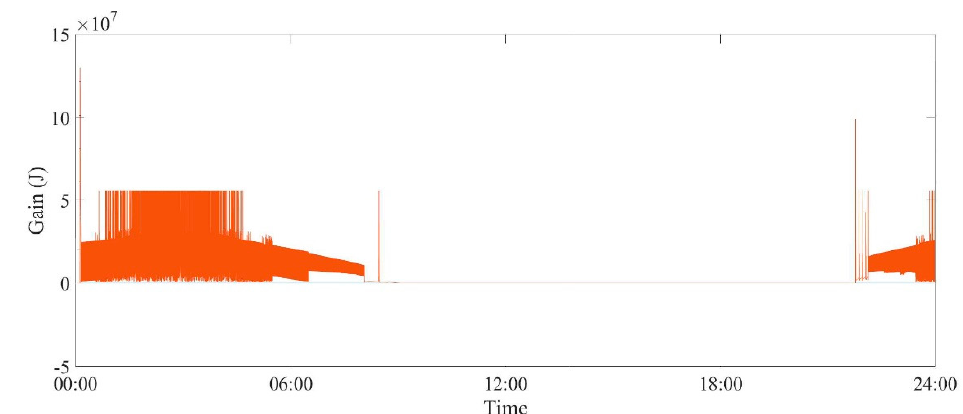
Figure 10. Energy use by Fuzzy Inference System (FIS) at a normal condition.